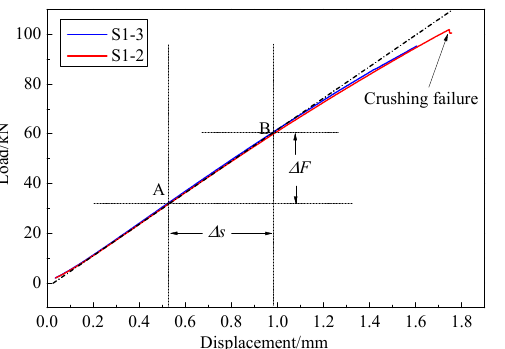
Figure 6. Compression load-displacement curves of specimens with shallow cracks.